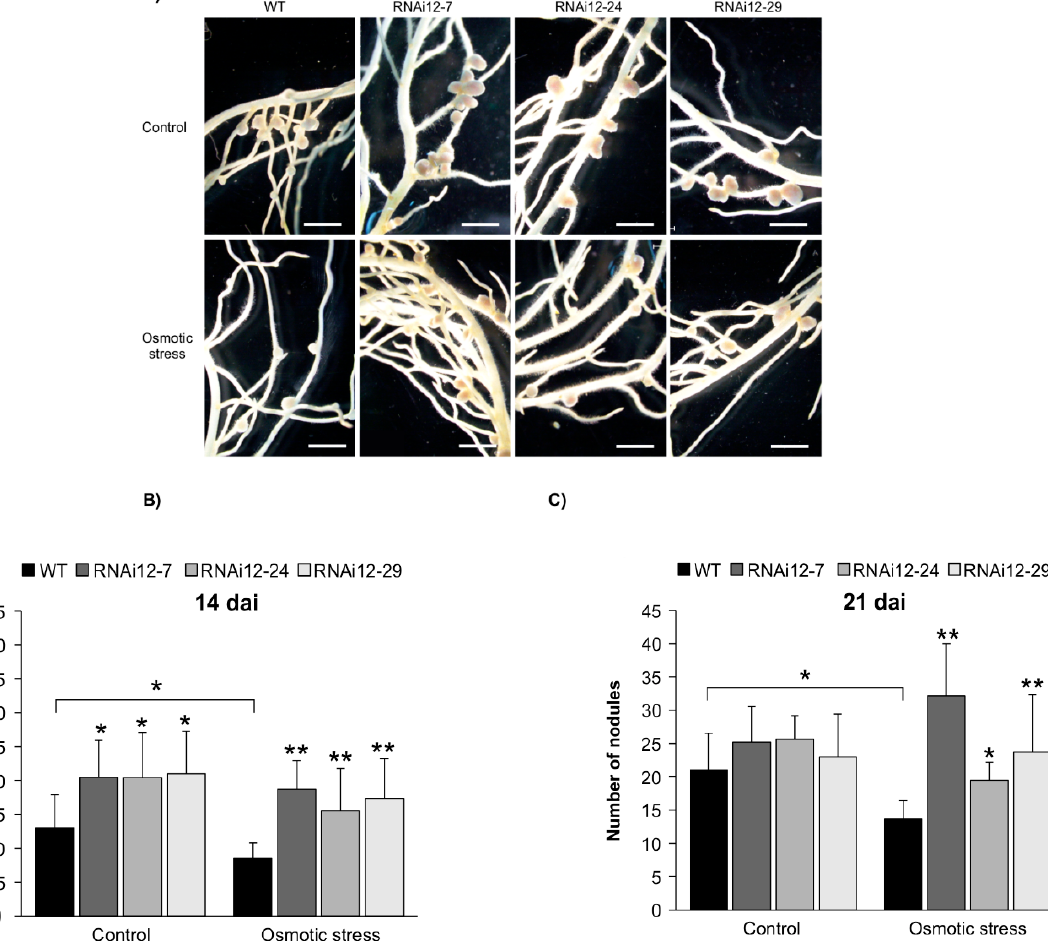
Figure 6. Effect of SPL12 silencing on nodulation under osmotic stress. ( A ) Phenotypes of nodules of WT and SPL12 -RNAi plants under osmotic stress (400 mM mannitol) at 21 dai. Scale bars: 2 mm. ( B ) The number of nodules in WT and SPL12 -RNAi alfalfa plants under control and osmotic stress conditions (n = 12–14) at 21 dai; and ( C ) at 14 dai (n = 10–12 plants). * and ** indicate significant differences relative to WT using Student’s t -test p < 0.05, p < 0.01, respectively. Error bar indicates standard deviation.